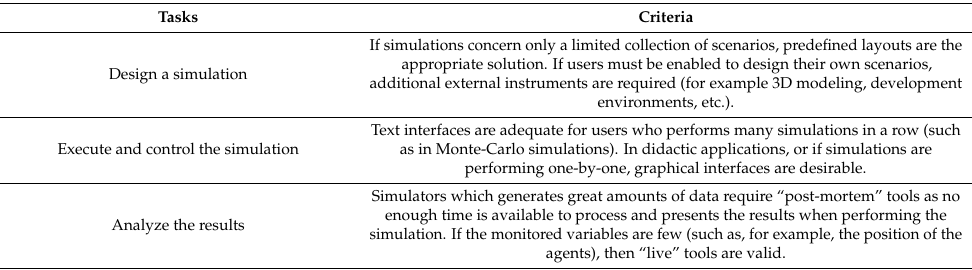
Table 9. Criteria for designing the user